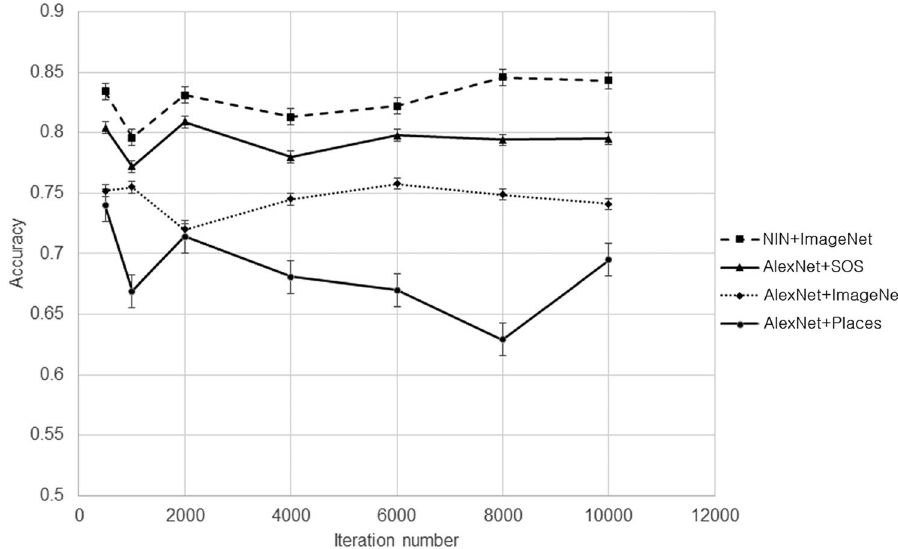
Figure 4. Accuracy trajectory of five systems according to changes in iteration number. Ranges for standard deviation are indicated by bars in NIN + ImageNet, AlexNet + SOS, and AlexNet + ImageNet.